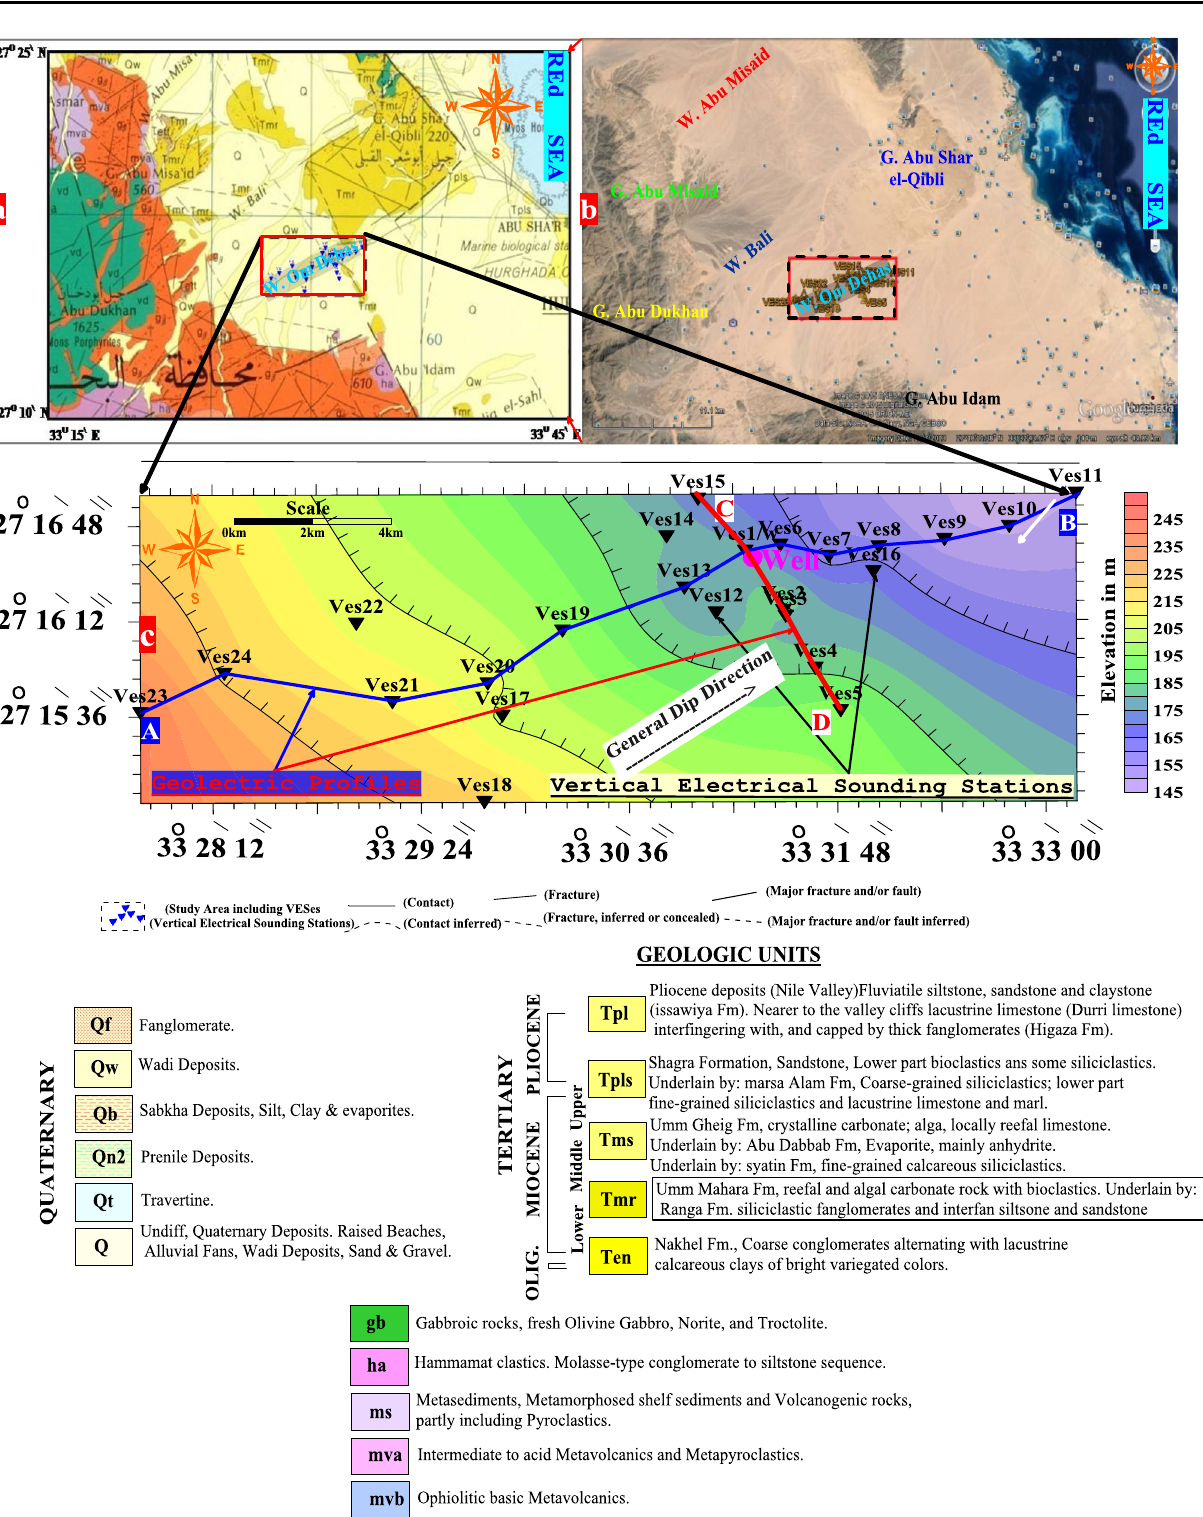
Fig. 1 General surface geological map including the study area of Wadi Om Dehas (Quadrangle Shape, dashed Line) ( a , b ) (after Conoco 1987, and Google Earth). The topographic map ( c ) including the distribution of the vertical electrical sounding stations (VESs),